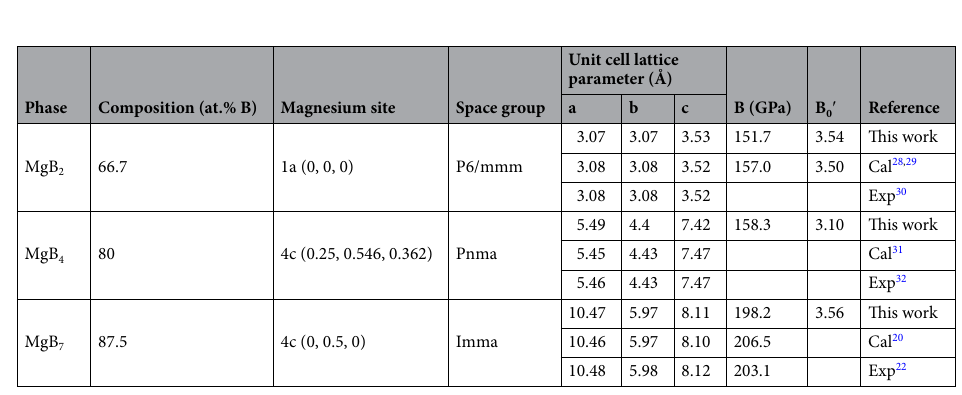
Table 1. The simulated structure parameter of Mg–B compounds contained lattice constant (Å), bulk modulus B, and its derivative B 0 ′ .